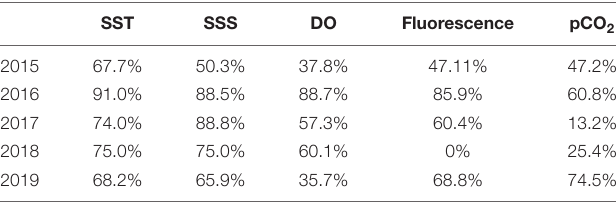
TABLE 1 | Percentage of data acquired for each parameter measured at the ASTAN buoy from March 2015 to December 2019. SST SSS DO Fluorescence pCO